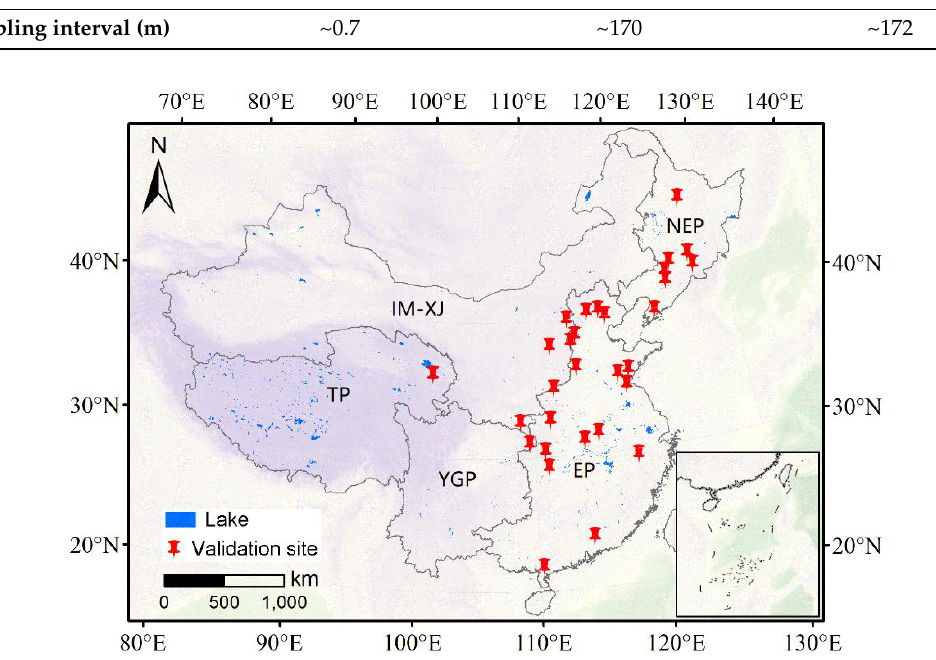
Figure 1. Distribution of lakes (and reservoirs) under this study and validation sites in China. In total,